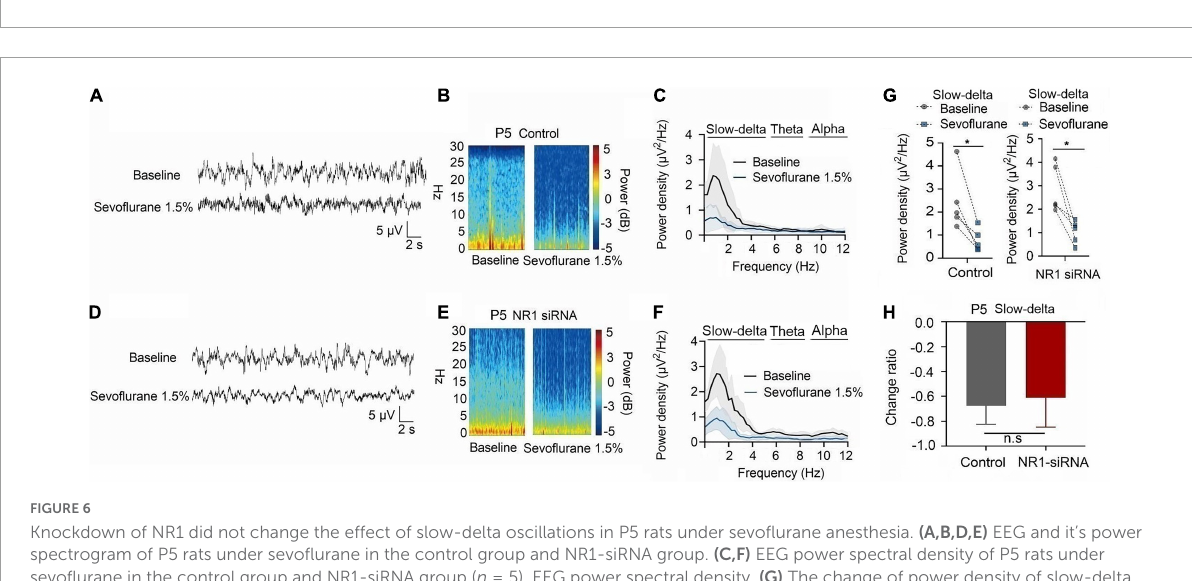
FIGURE5 Knockdown of NR1 did not change the effect of slow-delta oscillations in P5 rats under isoflurane anesthesia. (A,B,D,E) EEG and it’s power spectrogram of P5 rats under isoflurane in the control group and NR1-siRNA group. (C,F) EEG power spectral density of P5 rats under isoflurane in the control group and NR1-siRNA group ( n = 5). (G) The change of power density of slow-delta oscillations of P5 rats under isoflurane in the control group and NR1-siRNA group ( n = 5). (H) The change ratio of the power density of slow-delta, theta and alpha oscillations of P5 rats under isoflurane ( n = 5). Data are presented as mean ± SD. n.s., not significant; * P < 0.05, ** P < 0.01 by paired t -test (G) and unpaired t -test (H) .